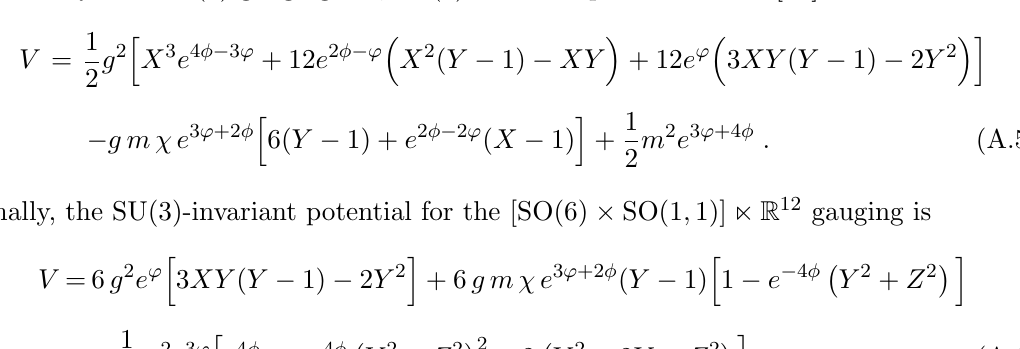
Table 6 . All critical loci of D = 4 N = 8 [SO(6) (cid:2) SO(1 ; 1)] n R 12 -gauged supergravity with at least SU(3) invariance. All of these are AdS. For each point we give the residual supersymmetry N and bosonic symmetry G 0 within the full N = 8 theory, their location in the parametrisation that we are using and the cosmological constant V 0 and the masses of the scalars in units of the AdS radius. The N = 0 SO(6) v vacuum is the (cid:31) = a = 0 point of the N = 0 SU(3) critical locus. For the dyonic ISO(7) gauging the, SU(3)-invariant potential reads